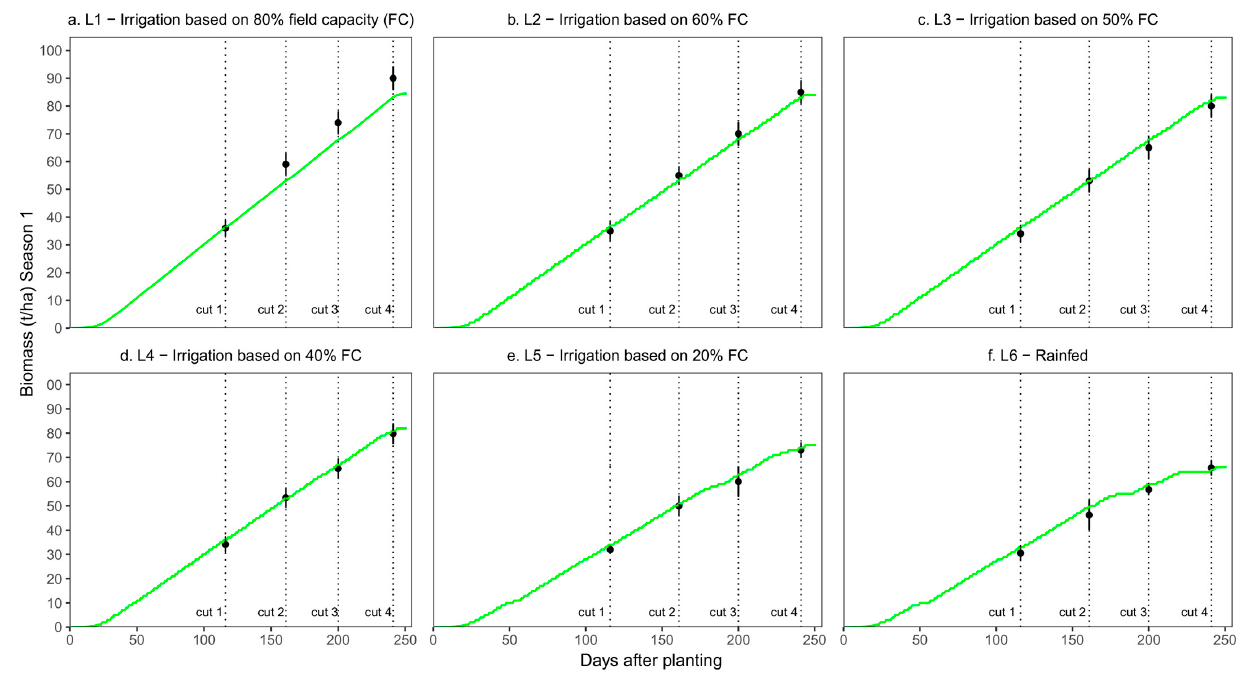
Figure 8. Observed and simulated cumulative biomass under different irrigation treatments during the first growing season (2020/21) of Guinea grass ( Megathyrsus maximus cv. Agrosavia sabanera). The error bars represent standard deviations. ( a ). Cumulative biomass for the treatment L1—irrigation based on 80% field capacity (FC); ( b ). Cumulative biomass for the treatment L2—irrigation based on 60% FC; ( c ) Cumulative biomass for the treatment L3—irrigation based on 50% FC; ( d ) Cumulative biomass for the treatment L4—irrigation based on 40% FC; ( e ) Cumulative biomass for the treatment L5—irrigation based on 20% FC; ( f ) Cumulative biomass for the treatment